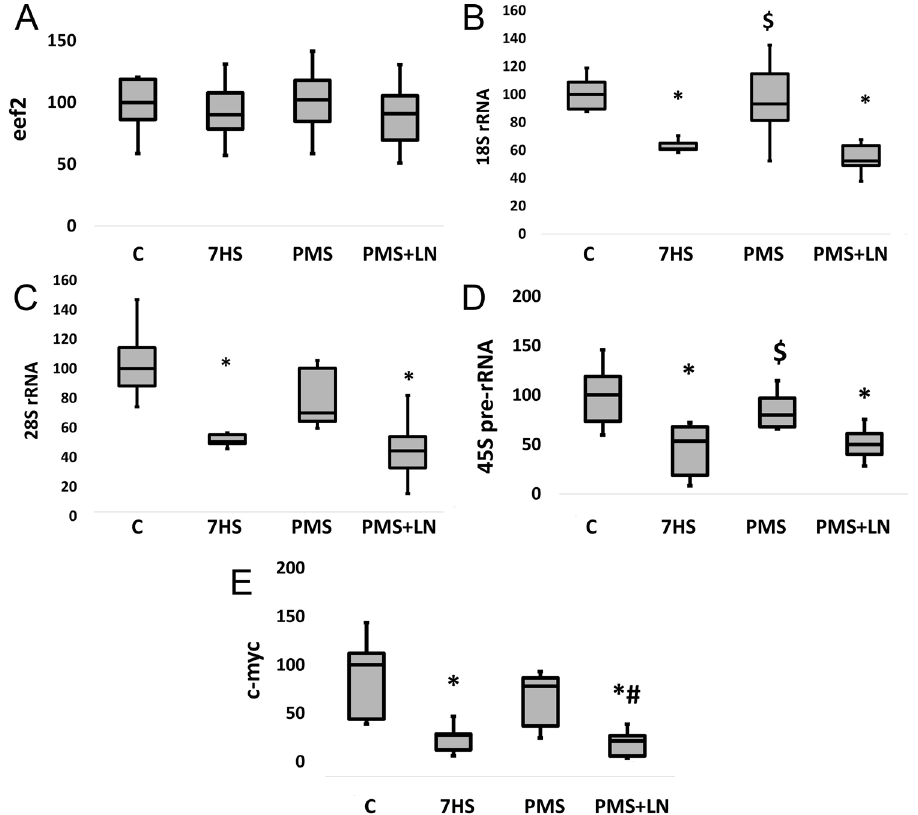
Figure 5. ( A ) eEF2 mRNA content. ( B ) 18S rRNA content. ( C ) 28S rRNA content. ( D ) 45S pre-rRNA content. ( E ) c-myc mRNA content. Control group ( C ); 7-days hindlimb-suspended group (7HS); 7-days hindlimb suspended group with plantar mechanical stimulation (PMS); 7-day hindlimb suspended group with plantar mechanical stimulation + L-NAME injection (PMS + LN). Data shown as % of control group. *Significant difference from control group. # Significant difference from PMS. $ Significant difference from 7HS ( p < 0.05). Blue dots correspond to the number of